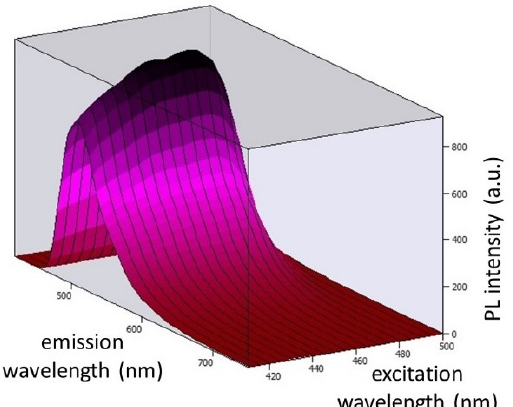
Figure 7. Three-dimensional photoluminescence spectra of Coumarin 6 dye embedded in EVA polymer at excitation wavelengths ranging from 410 nm to 500 nm and emission wavelengths ranging from 450 nm to 750 nm.